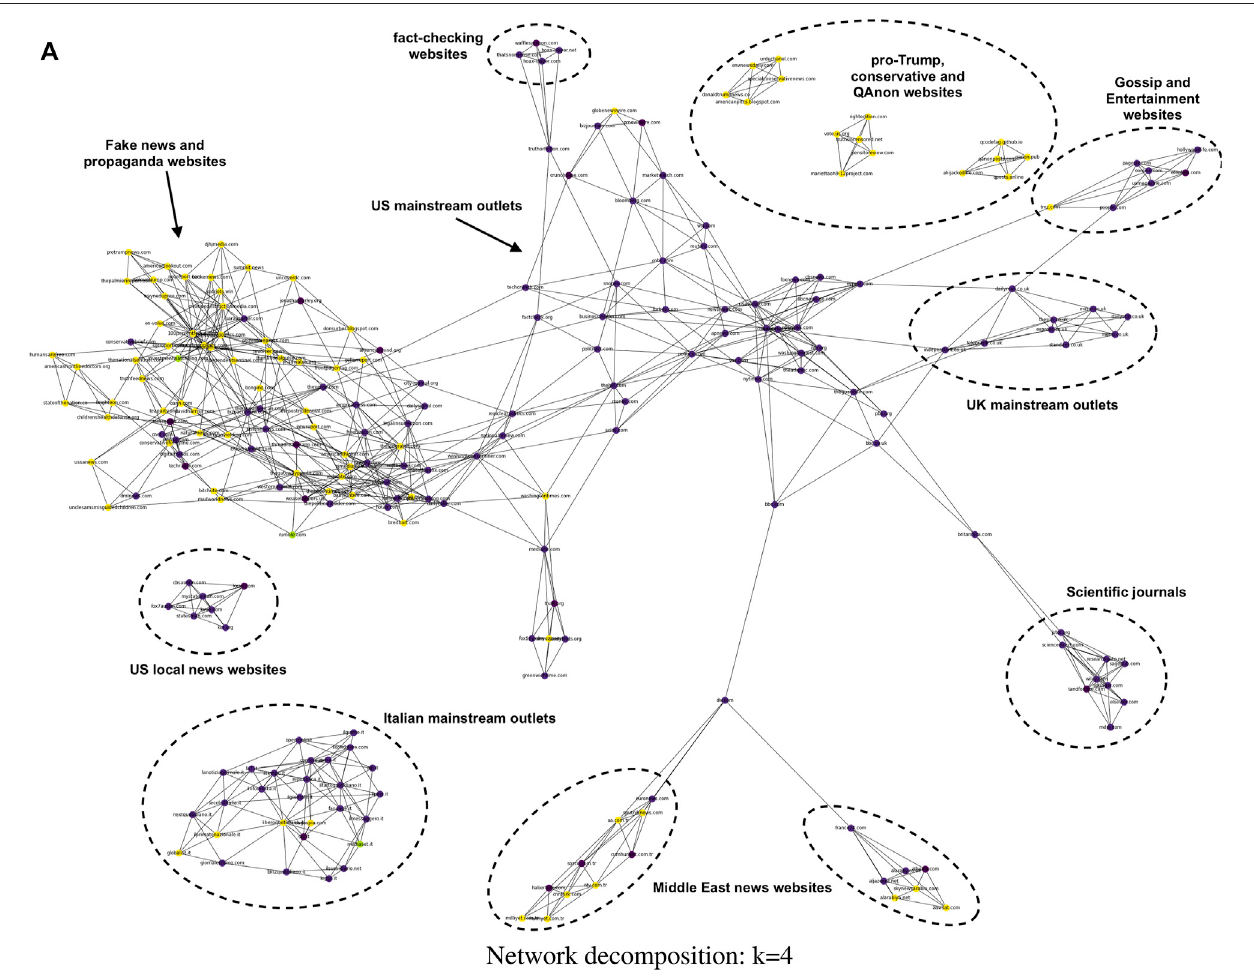
FIGURE6| k-coresofthegraphwithreliableandunreliablenewswebsitesandtheirnearestneighbors.Theremaining fi guresshowthe4-core (A) and5-core (B) in the fi ltered network. The colors in (A) and (B) refer to the labels assigned to each website: sea green nodes represent reliable websites ( “ True ” or “ Mostly True ” ); yellow nodesrepresentunreliablewebsites( “ False ” or “ MostlyFalse ” );andpurplenodesarewebsiteslabeledas “ Neutral. ” Ourresultshighlighttheimportanceofcorenodesfor detecting disinformation spreaders. An example is provided in the 4-core network (A) , where the small sub-network of Pro-Trump and conservative sites includes websites (e.g., urduchanel.com and donaldtrumpnews.co) linked to fake news and hyper-partisan content [41] .